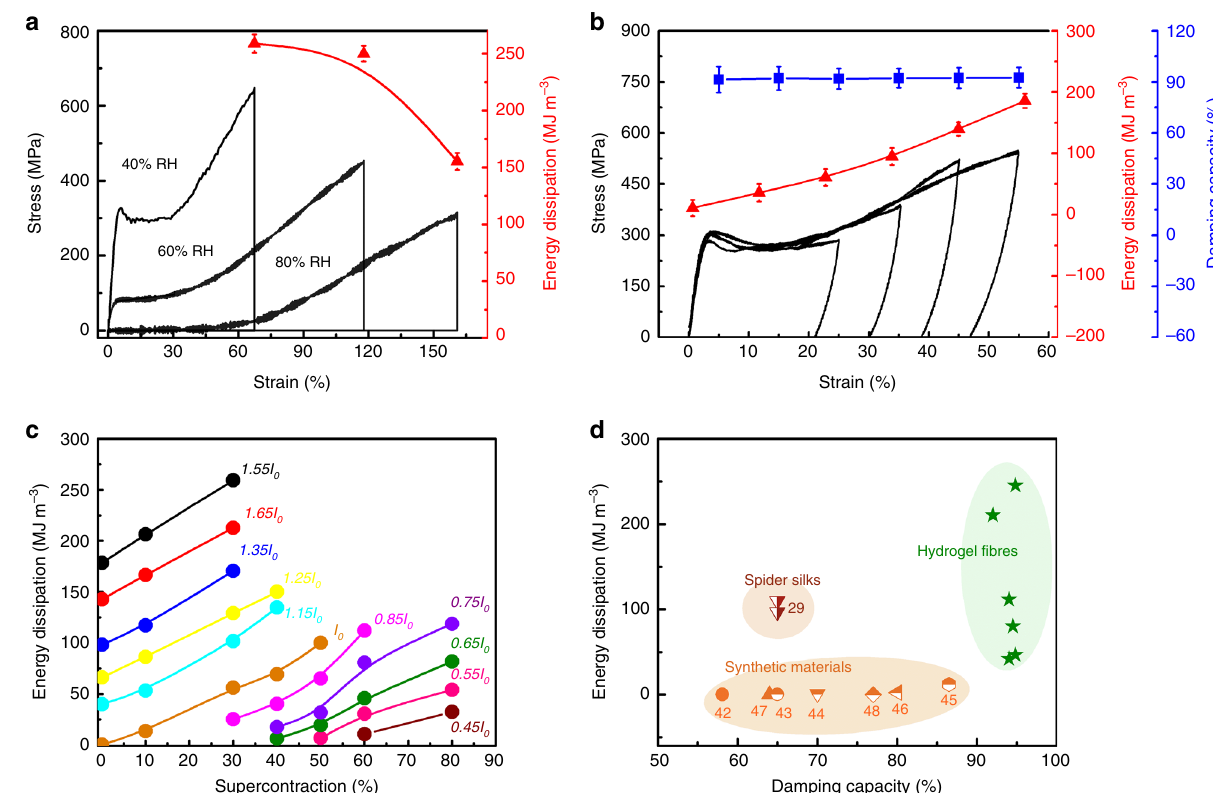
Fig. 3 Energy-dissipation properties of hydrogel fi bres. a Stress-strain curves and energy dissipation of hydrogel fi bres at different humidity values. b Stress-strain curves, damping capacity, and energy dissipation of hydrogel fi bres progressively stretched to different strains. c Energy dissipation of hydrogel fi bres supercontracted to different degrees and stretched to different lengths. l 0 : initial length of the hydrogel fi bre. For a – c the twist density was 3 turns mm − 1 , and the deformation rate was 27.8% s − 1 . d Comparison of the energy dissipation and damping capacity of the hydrogel fi bres (green stars) in this work with those of other typical energy-dissipation materials, such as spider silks (red symbols) and synthetic materials (yellow symbols), reported in the literature. The numbers shown in the graphs correspond to the references. The hydrogel fi bres presented different twist densities and were tested at different deformation rates. All the hydrogel fi bres contained 0.1 wt% VSNPs and 20 mM ZnCl 2 . The studies with both the energy dissipation and damping capacity data reported are selected. The error bars mean the s.d. from fi ve